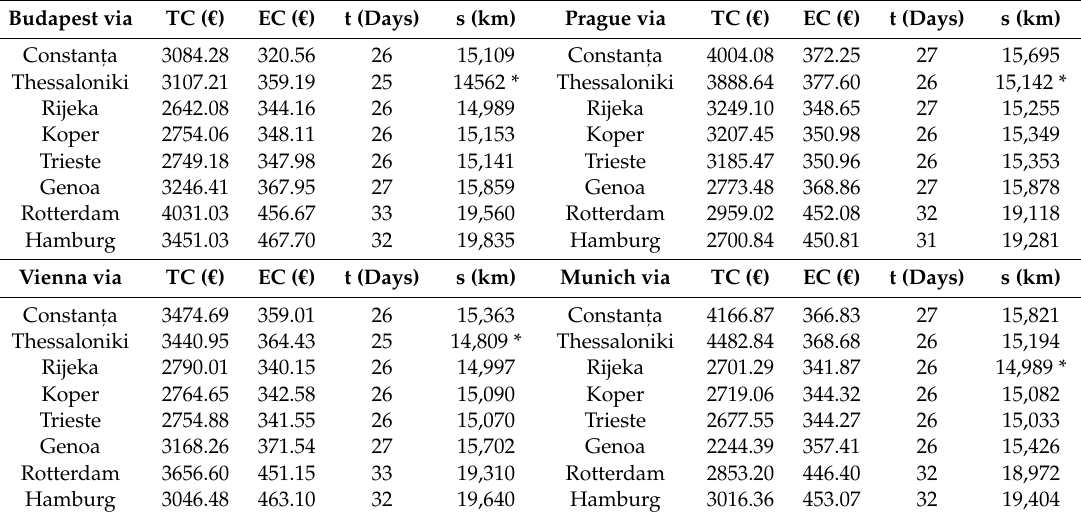
Table 2. Transport costs per unit (TC), external costs per unit (EC), transport time (t) and distance (s) on the maritime-rail route from Shenzhen (CHN) to Central European